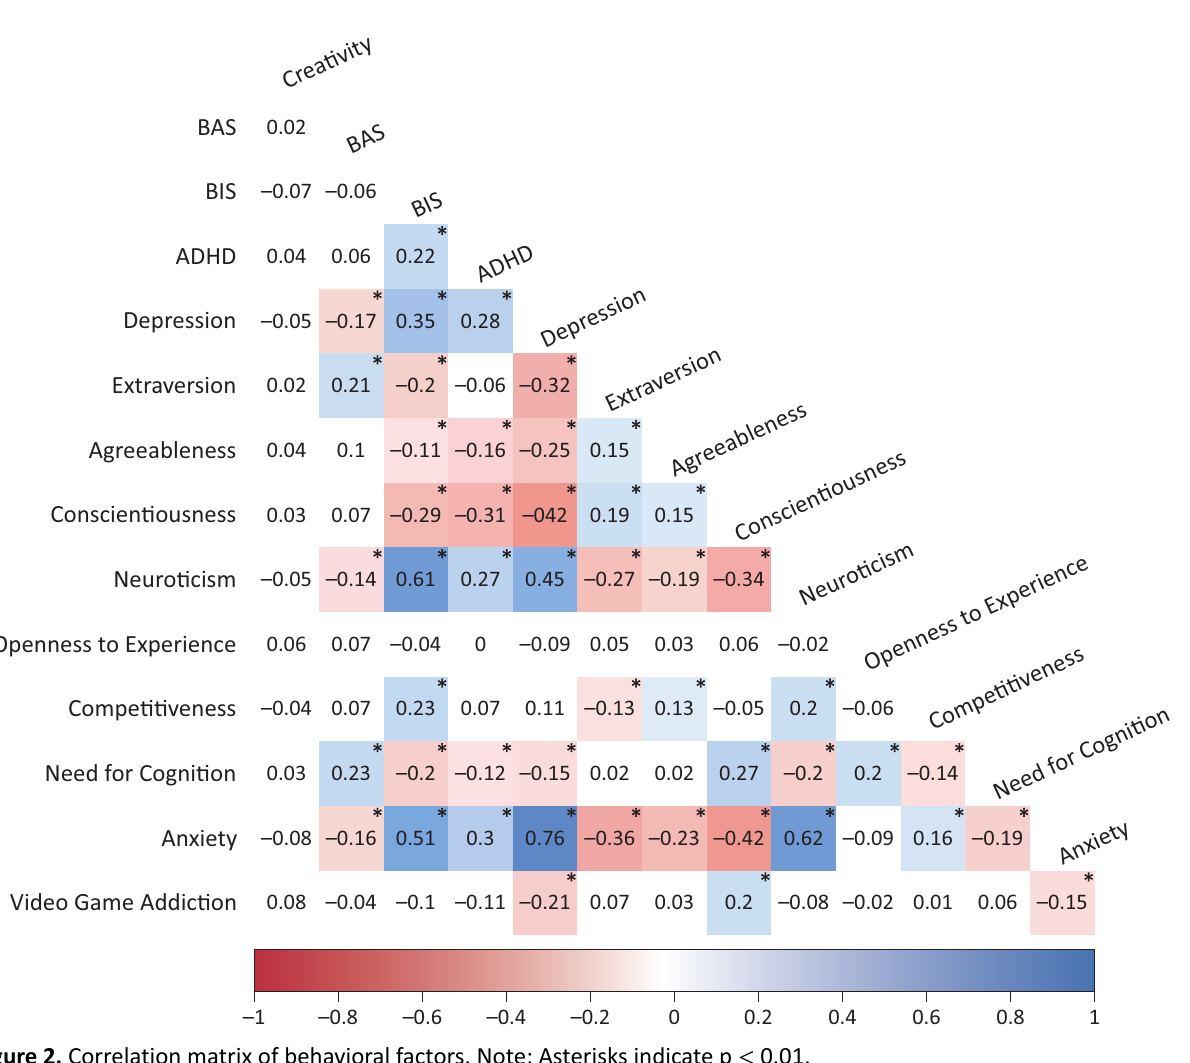
Figure 2. Correlation matrix of behavioral factors. Note: Asterisks indicate p <